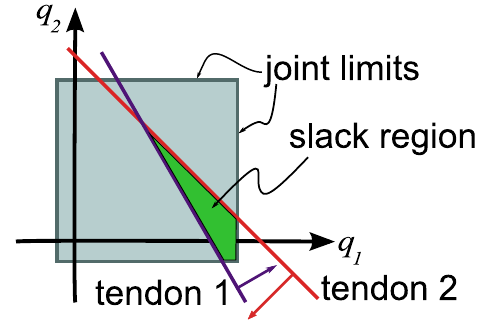
Figure 3. The slack space (shaded region) is bound by the two constraints (lines) and the joint limits (box).